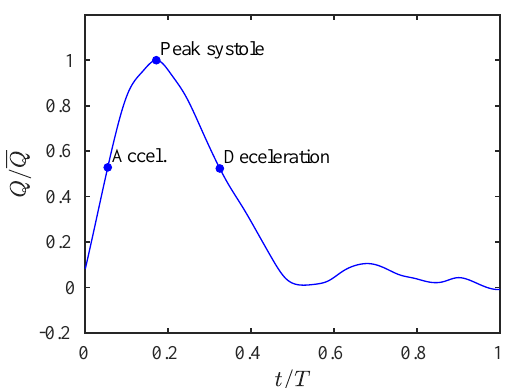
Figure 5. Inlet flow rate profile. The curve is parametrized by the maximum flow rate Q and the cardiac cycle duration T . Three points of the cycle are also highlighted and will be used in Section 3.